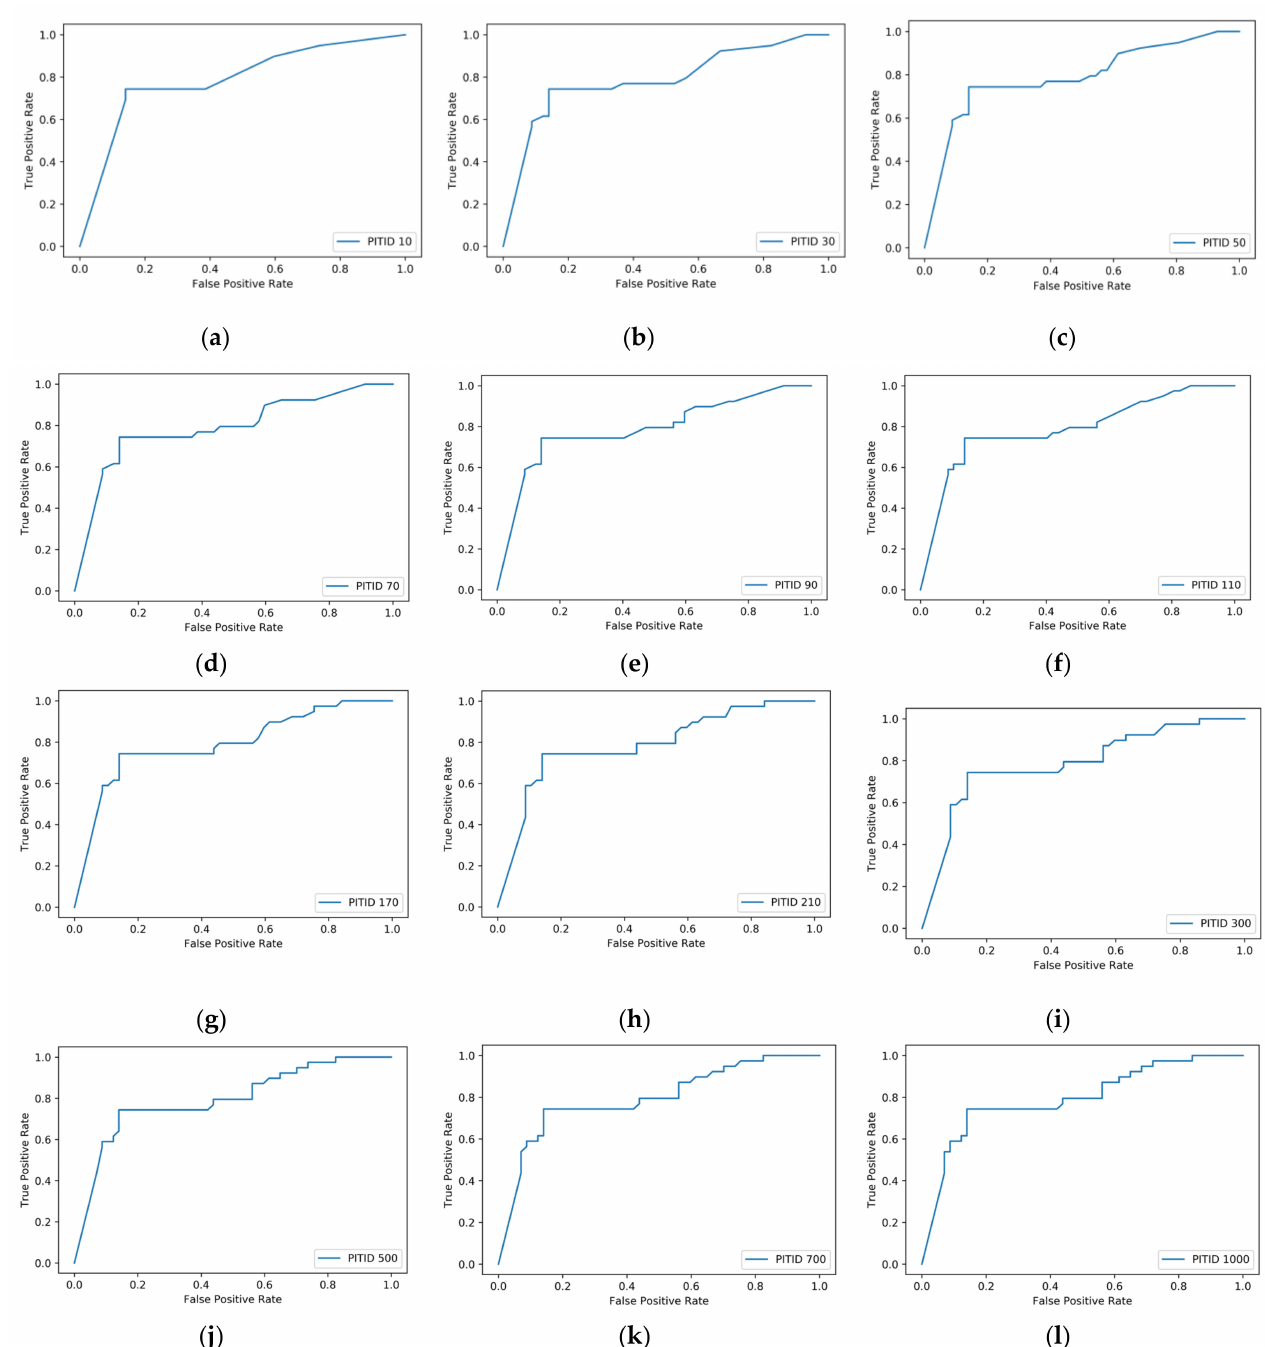
Figure 6. Comparison of the number of decision trees of Random Forest: ( a ) shows ROC curves for DT = 10, ( b ) shows ROC curves for DT = 30, ( c ) shows ROC curves for DT = 50, ( d ) shows ROC